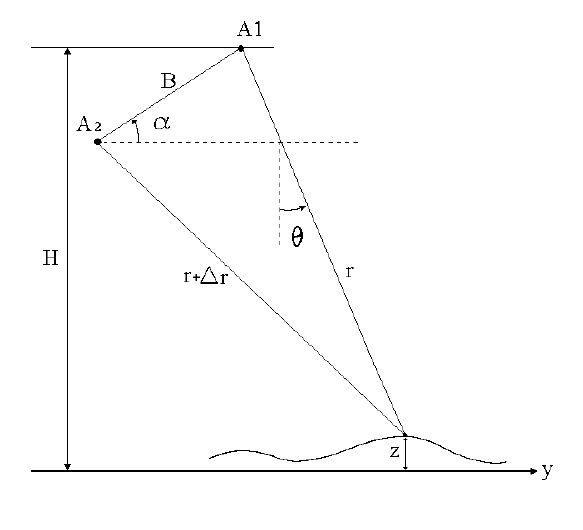
Figure 1. Basic geometry of an interferometric SAR